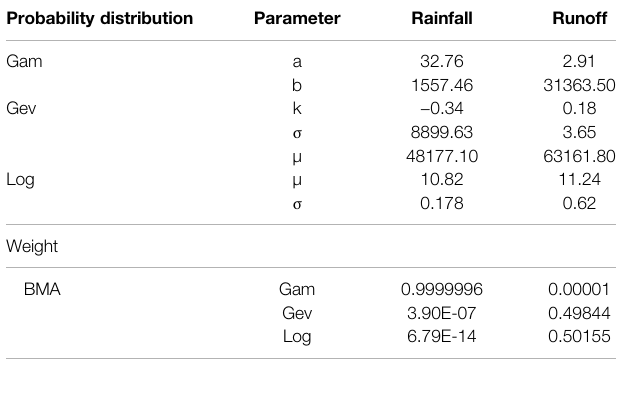
TABLE 1 | The fi tting parameters of probability